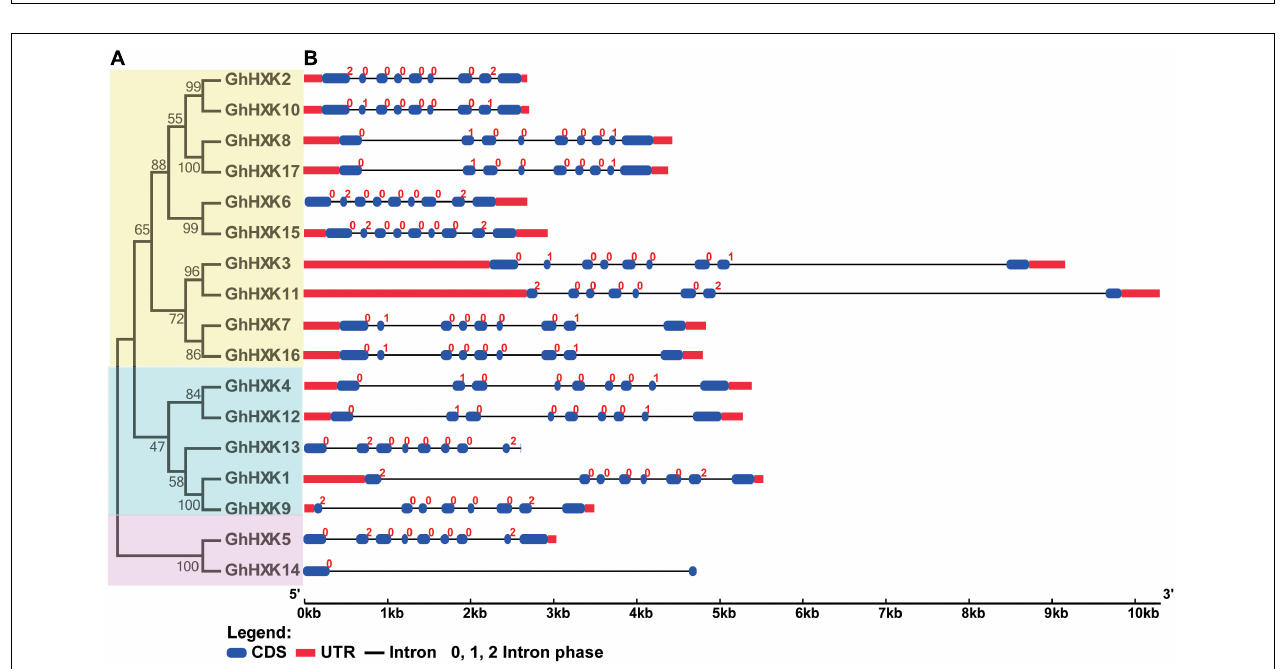
FIGURE 3 | The phylogenetic tree (A) and gene structure (B) of GhHXKs . The phylogenetic tree was constructed with the CDS sequences of GhHXKs by MEGA 7.0 software with default parameters. The exons, UTR, and introns are indicated by blue ovals, red rectangles, and black lines, respectively.